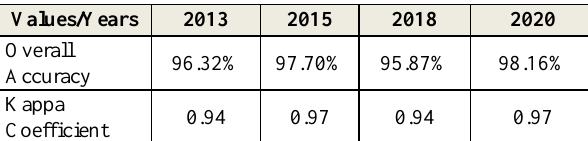
Table 1. Land Use Status of Working Years